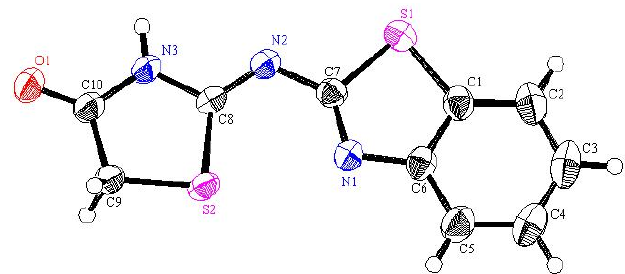
Figure 3. ORTEP plot of the X-ray crystallographic data determined for 3c . Crystallo- graphic data have been deposited with the Cambridge Crystallographic Data Centre as supplementary publication number CCDC 874281 [30].